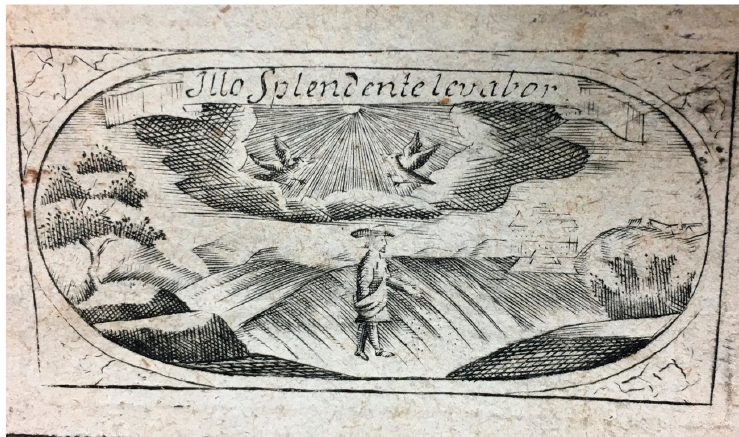
Figure 5. A 1740 version of the seal (Niekamp 1740). Johann Lucas Niekamp, ed. Kurtsgefastzte